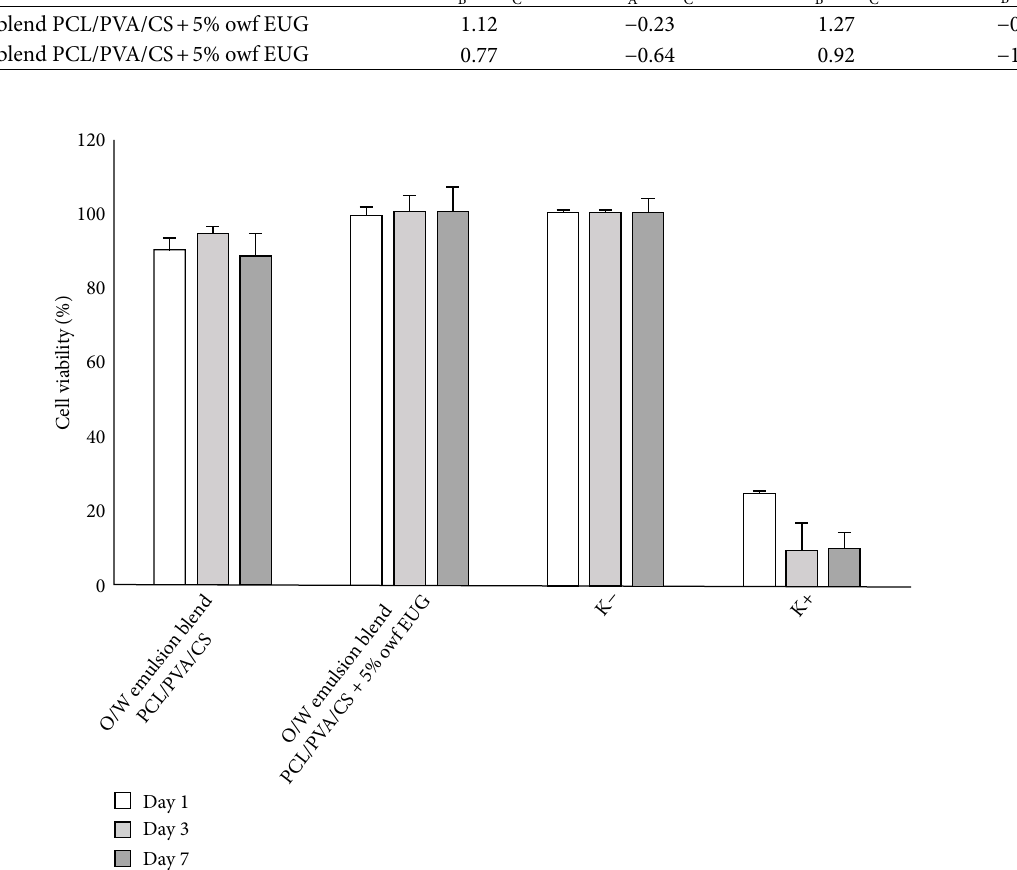
Table 3: Antibacterial activity values (bacteriostatic and bactericidal activity values). Samples